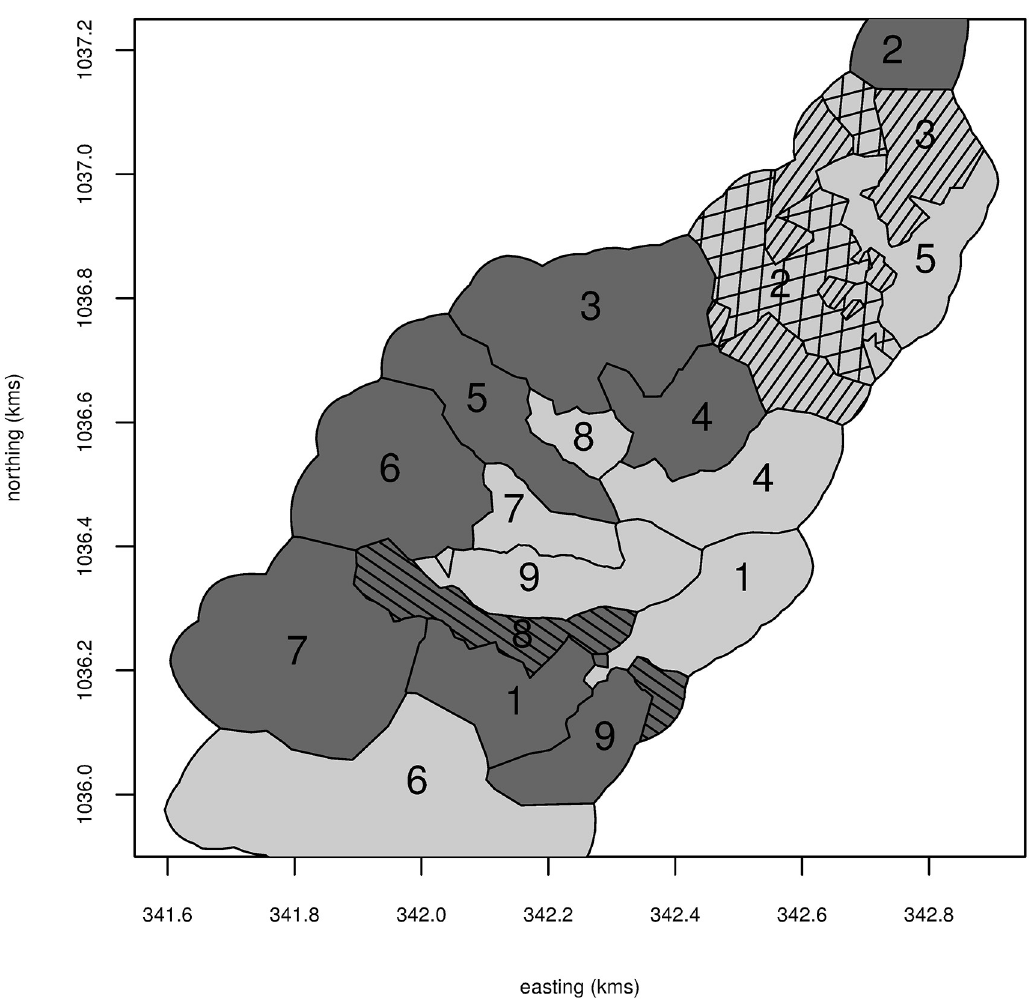
Fig 2. Pairing of clusters in the Trujillo trial. Darker clusters are in the intervention arm. Clusters with the same number are in the same matched pair (one in the intervention and one in the control arm). Hatching is used to show different sections of clusters which appear to be non-contiguous, due to limited GPS accuracy and steep